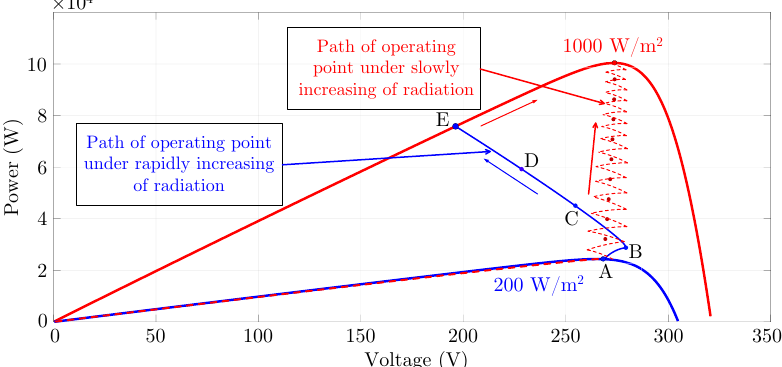
Figure 5. Path of the PV array’s operating point with the P&O algorithm under slowly and rapidly changing radiation (Adapted from [23]).